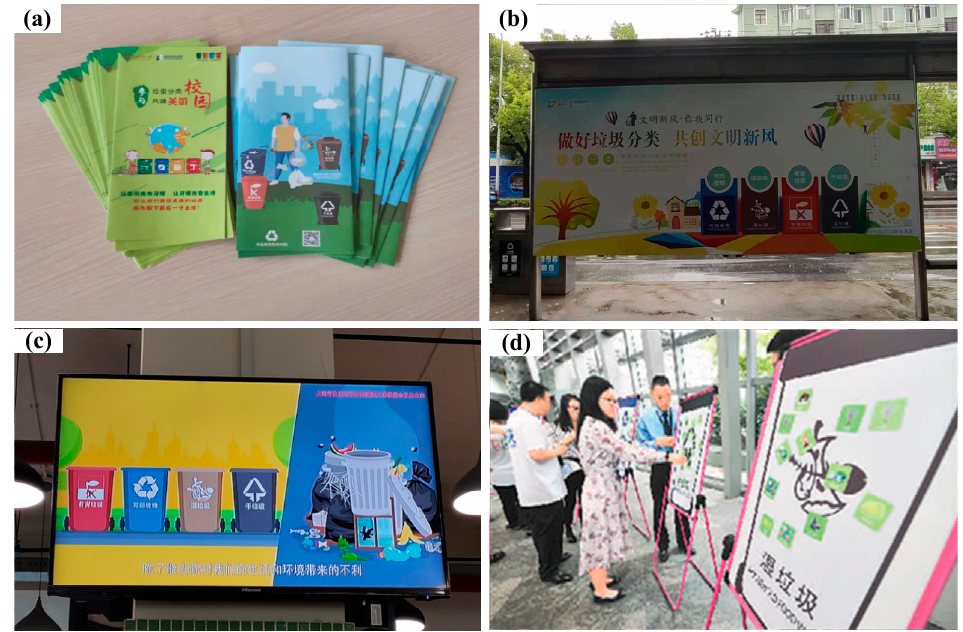
Figure 3. Pictures of municipal solid waste (MSW) classification publicity: ( a ) brochures, ( b ) poster, ( c ) television video, ( d ) promotional activity [26].